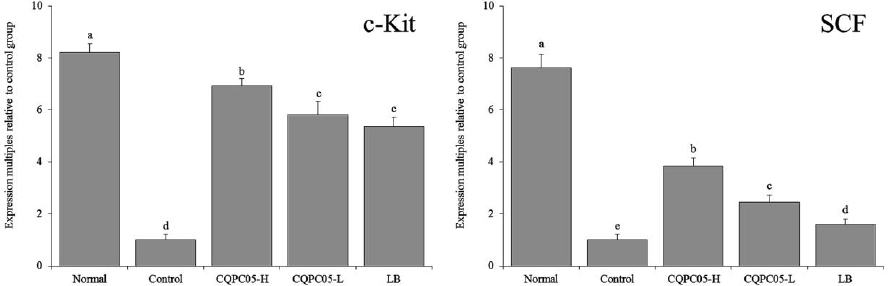
Figure 6. The small intestine tissue levels of mRNA expression of c-Kit and SCF in the Lactobacillus plantarum CQPC05 and Lactobacillus delbrueckii subsp. bulgaricus treated activated carbon-induced constipation mice. a − e The different letters mean that there are significant differences ( p < 0.05) between every two groups according to Duncan’s multiple range test. LB: Lactobacillus delbrueckii subsp. bulgaricus (1.0 × 10 9 colony-forming unit (CFU)/kg body weight (bw)); CQPC05-L: Lactobacillus plantarum CQPC05 low dose (1.0 × 10 8 CFU/kg bw); CQPC05-H: Lactobacillus plantarum CQPC05 high dose (1.0 × 10 9 CFU/kg bw). SCF: stem cell factor.